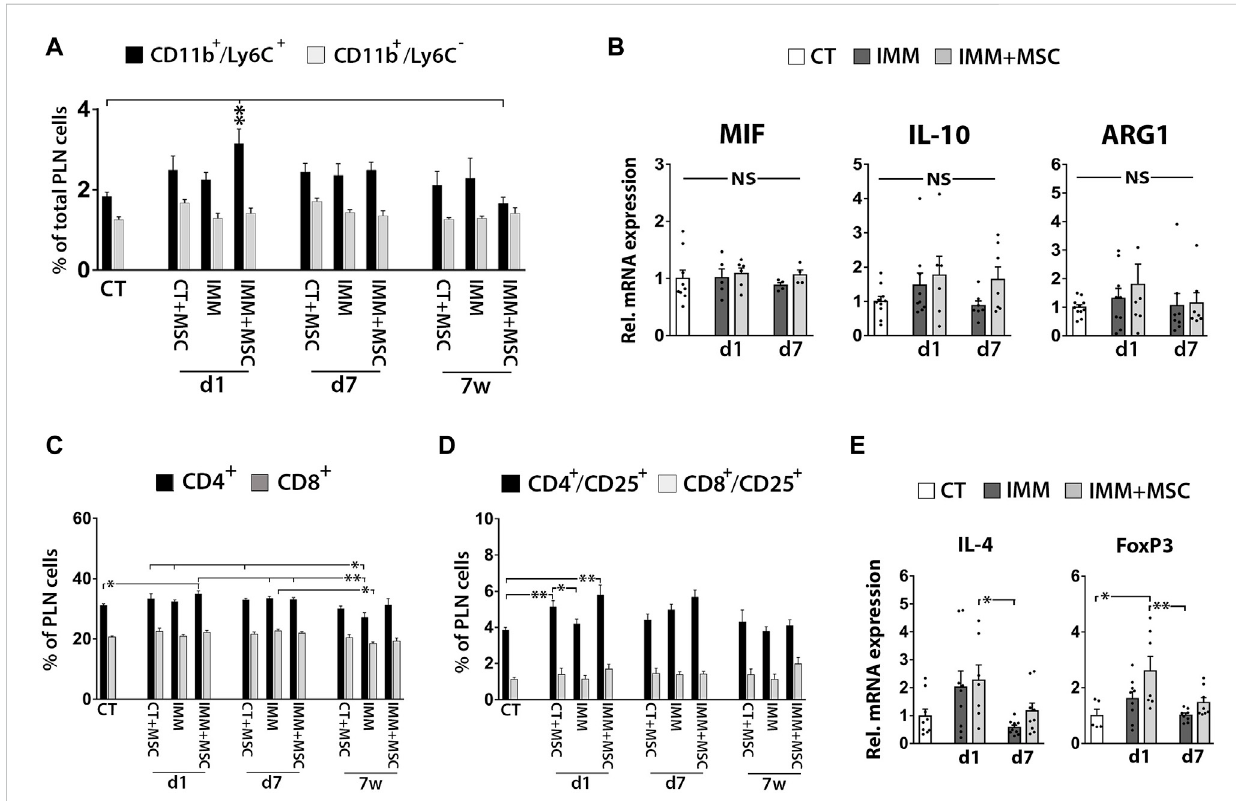
FIGURE 6 Immunized RIP-B7.1 transplanted with UC-MSC display transiently increased MDSC, activated T Cells and regulatory T Cells markers in pancreatic lymphnodes. (A) Quanti fi cationofCD11b + /Ly6C − andCD11b + /Ly6C + MDSCwithinpancreaticlymphnodes(PLN).NotehowPLNfromday1-transplanted IMM mice display increased percentage of CD11b + /Ly6C + MDSC. (B) Q-PCR analysis of MIF, IL-10 and ARG1 mRNA expression in PLN. Results show relativemRNAexpressiontoCTmice(valuesetas1). (C – E) PLNfromday1UC-MSCtransplantedIMMmicetransientlydisplayhigherpercentagesof total and activated CD4 + T Cells, correlating with higher expression of the regulatory T Cells markers forkhead box P3 (FoxP3). (C) Summary fl ow cytometric quanti fi cation of total CD4 + and CD8 + T Cells in PLN. (D) Quanti fi cation of activated CD4 + /CD25 + and CD8 + /CD25 + T Cells in PLN. (A, C, D) SplenocyteswerecollectedfromCTandIMMRIP-B7.1mice,at24 h,7 daysand7 weekspost-transplantationwithvehicleor5×10 5 UC-MSC. (E) Q-PCR analysis of interleukin-4 (IL-4) and FoxP3 mRNA expression in PLN. (B, E) PLN were collected from CT and immunized RIP-B7.1 mice transplanted with vehicle (IMM) or 5 × 10 5 UC-MSC (IMM + MSC) at day 1 and 7 post-transplantation. (A – D) Values are mean ± s. e.m of n ≥ 5 mice for each experimental group. *, p ≤ 0.05; **, p ≤ 0.03; ***, p ≤ 0.01, one-way ANOVA. NS is for not signi fi cant